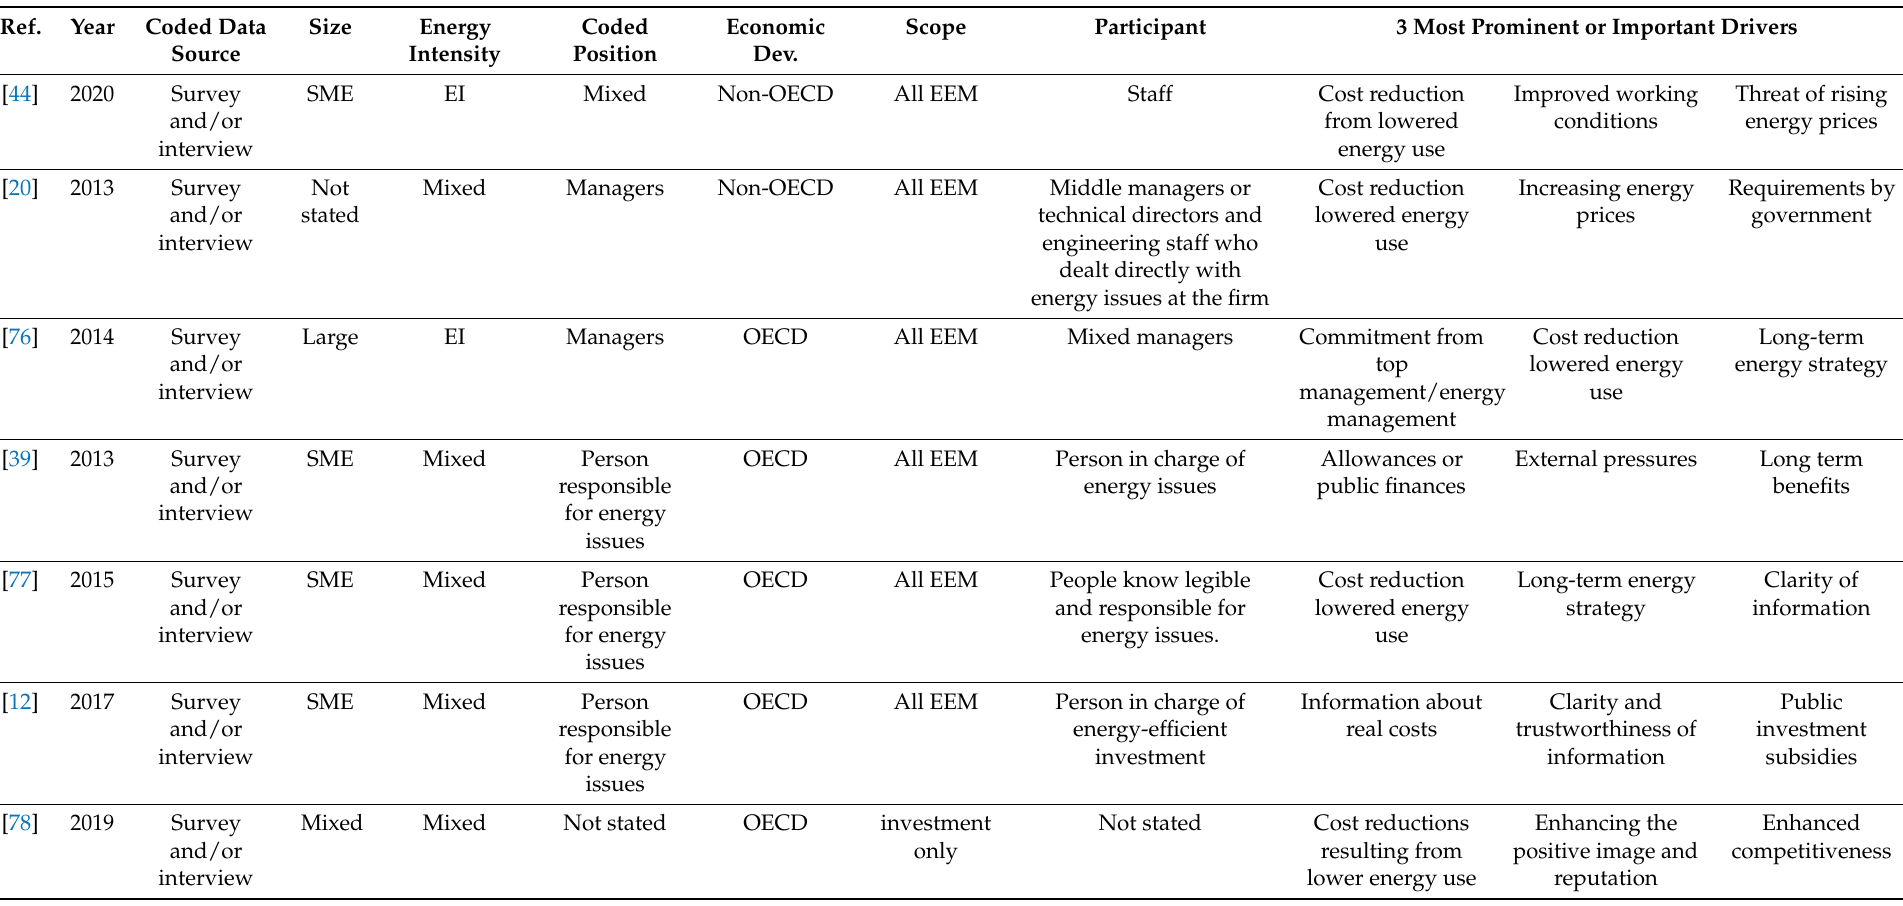
Table A3. Systematic literature review drivers for papers using survey and interview as a data source.